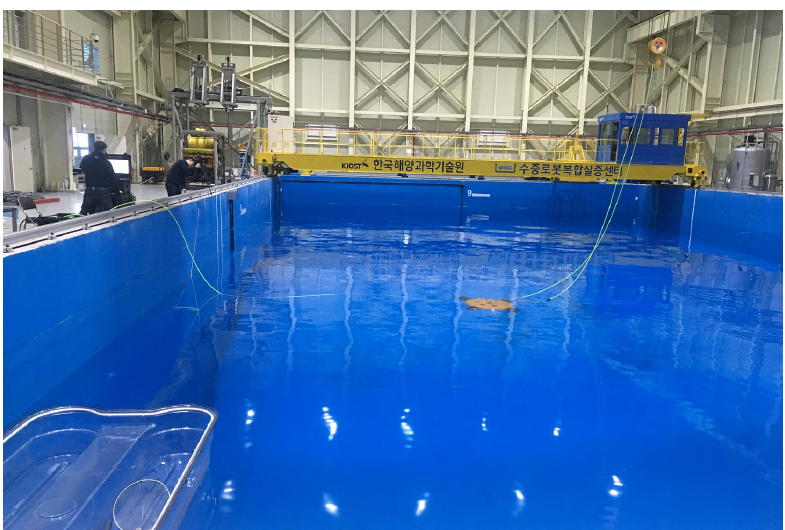
Figure 9. Maximum forward speed test in the engineering basin.